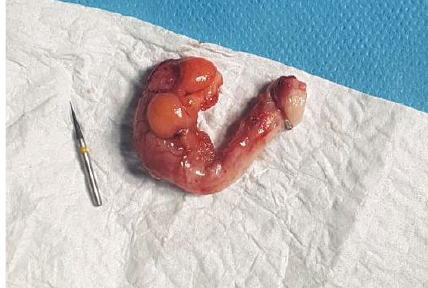
Figure 3: In fl amed appendix and the metal